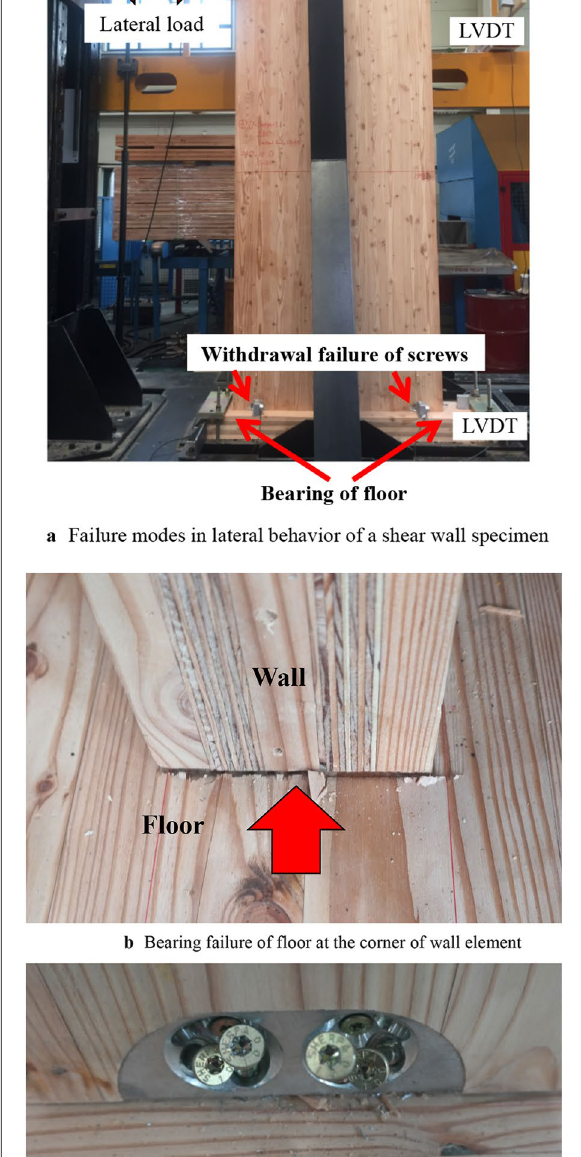
Fig. 8 Lateral behavior and failure modes of a shear wall